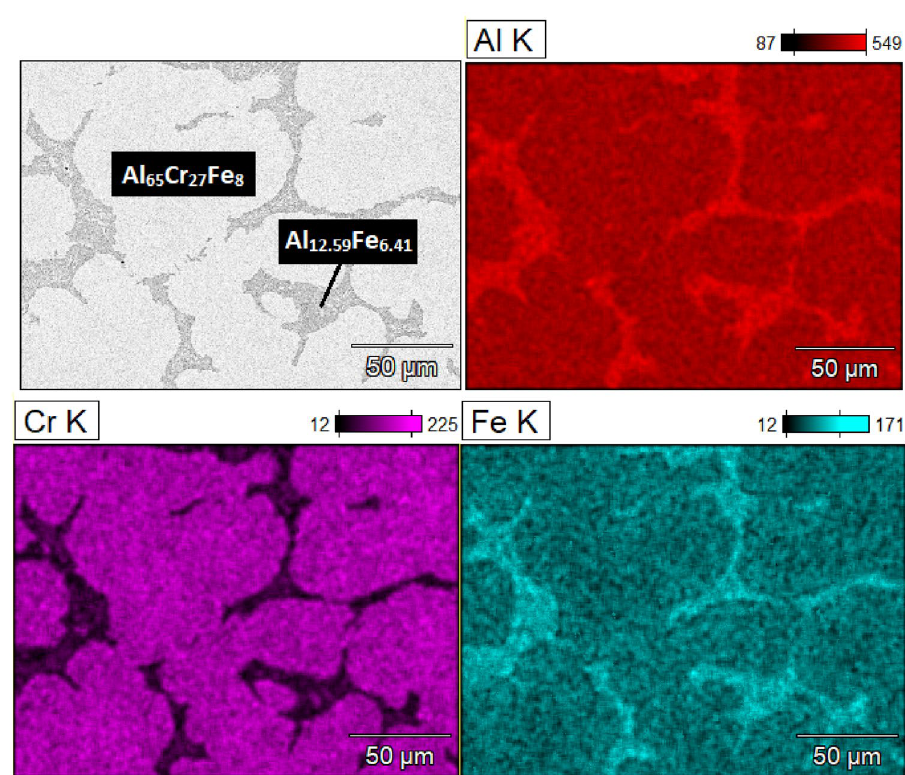
Figure 2. EDX maps of Al 65 Cr 20 Fe 15 alloy in a form of